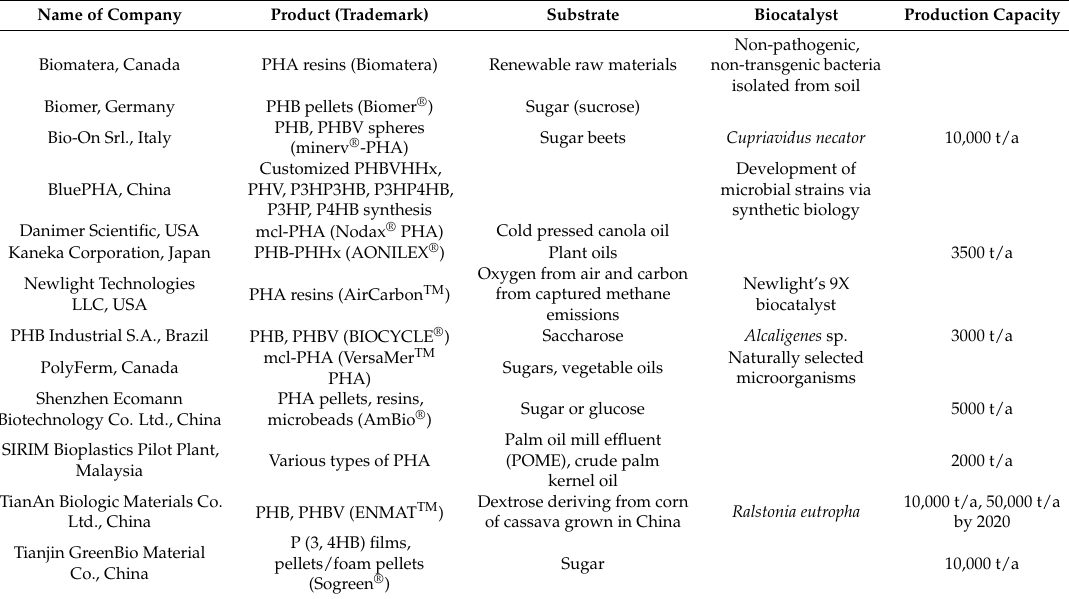
Table 1. Pilot and industrial scale PHA manufacturers currently active